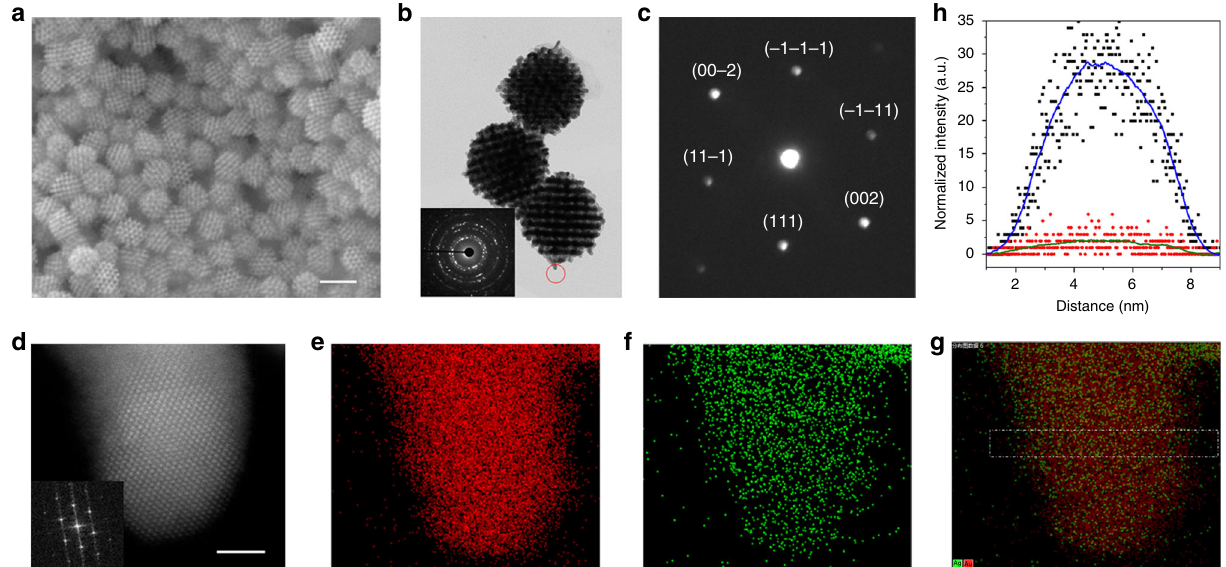
Fig. 2 The characterization analysis of the 3D ordered mesoporous AuAg networks. a , b The typical SEM and TEM images of the 3D ordered mesoporous AuAg networked structures synthesized via the proposed soft-enveloped SLS interface reaction. c The [1 – 10] zone axis nanobeam electron diffraction pattern, displaying typical {200} and {111} Bragg re fl ections of fcc, Au, or Ag. d – g Representative HAADF-STEM image in combination with EDX element maps. Inset in d is the fast Fourier transformation (FFT) patterns of the STEM images. h The composition line pro fi les obtained by EDX with an electron beam (~1.5 Å in spot size) scanning across the region marked in g . The scale bars in a and d are 100 and 2 nm,